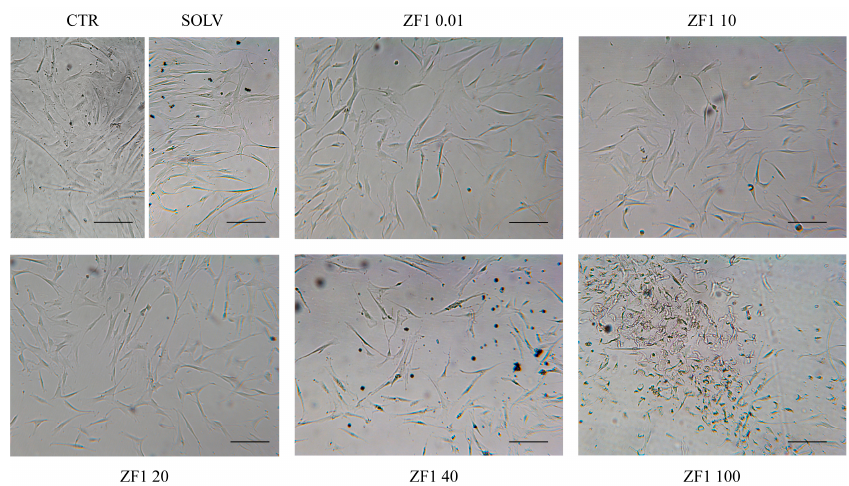
Figure 2. Representative images of hASCs treated with ZF1 at different concentrations (0.01, 10, 20, 40, and 100 μ g/mL) or with a solvent (SOLV) or untreated (CTR). Cytotoxicity was evaluated with a morphological analysis. Images were obtained with an optical microscopy (40× magnification and bright field illumination). Scale bar corresponds to 200 μ m.